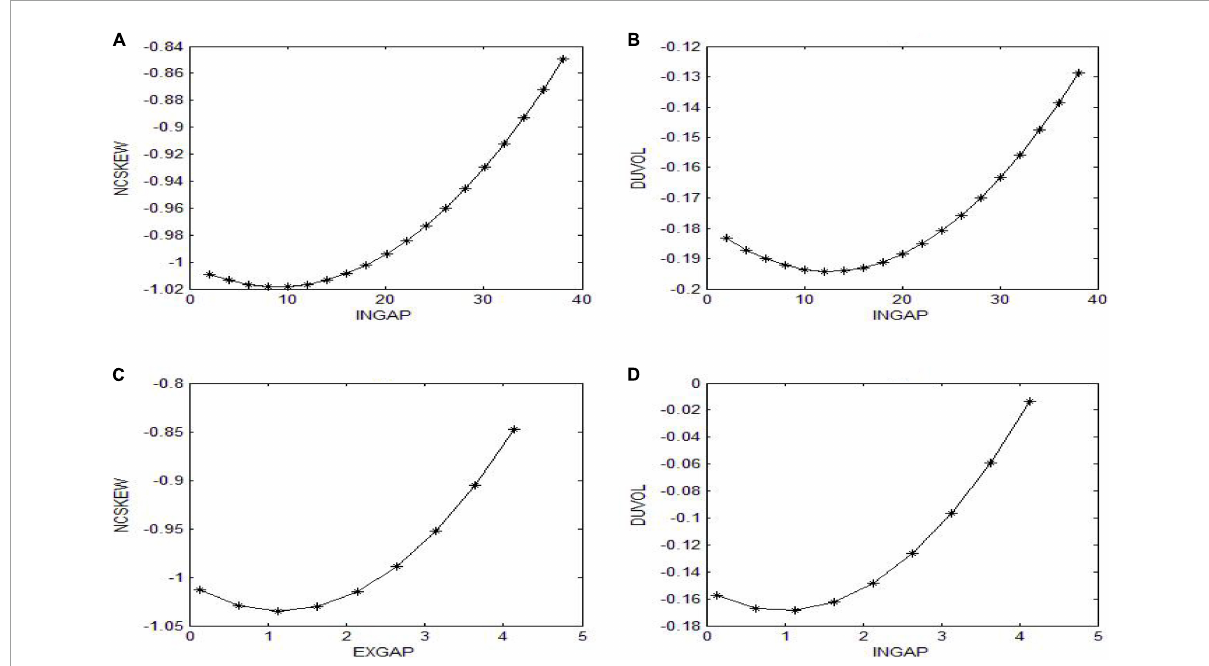
FIGURE1 U-shaped curve of the pay gap and stock price crash risk. (A) U-shaped curve of the INGAP and NCSKEW. (B) U-shaped curve of the INGAP and DUVOL. (C) U-shaped curve of the EXGAP and NCSKEW. (D) U-shaped curve of the EXGAP and